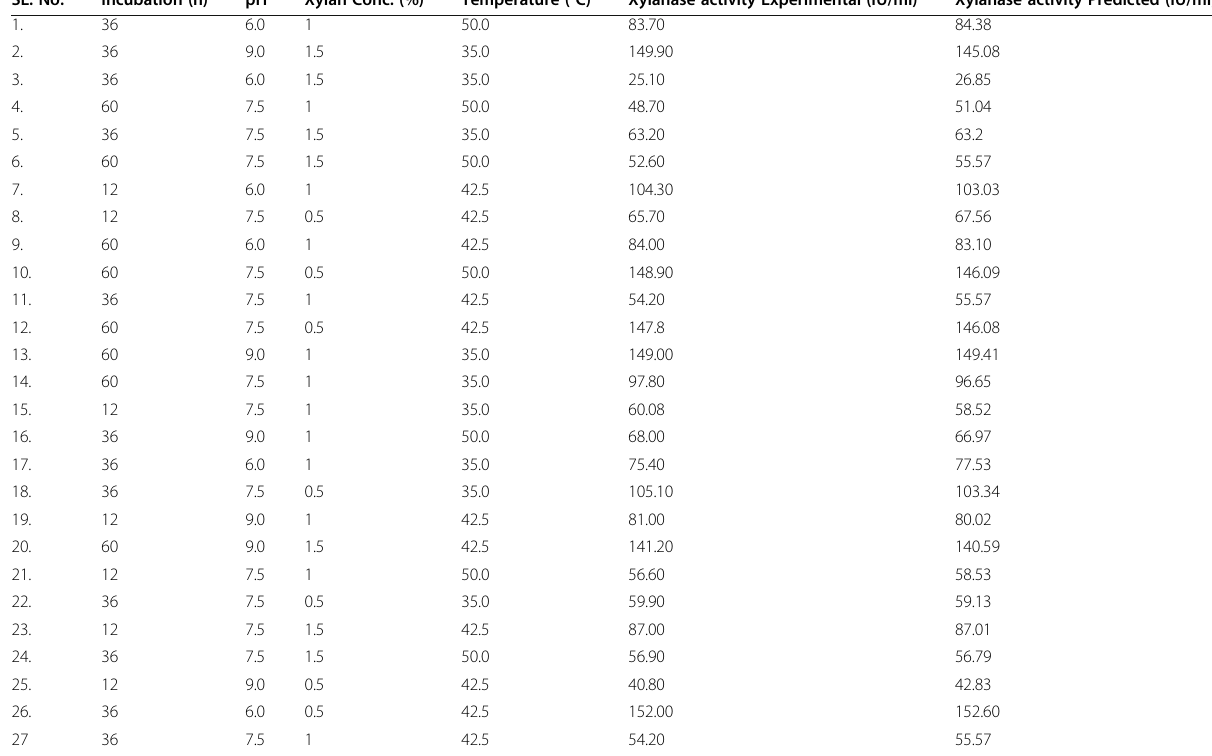
Table 4 Optimization of fermentation parameters using response surface methodology with Box-Behnken design SL.